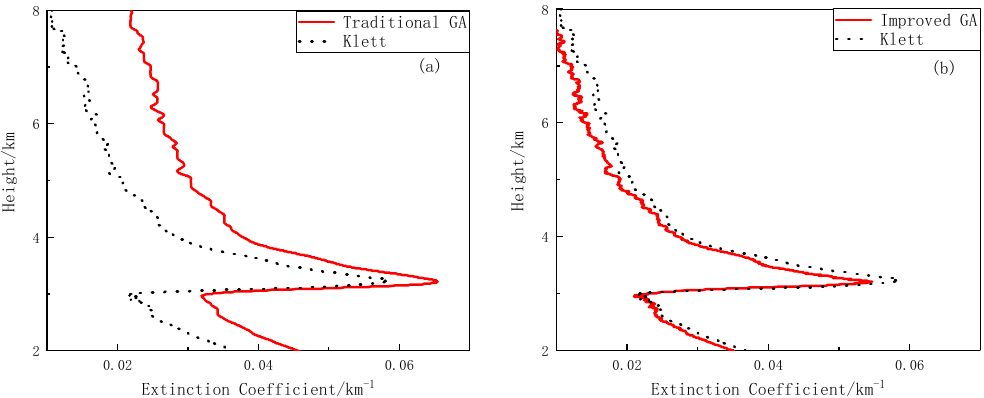
Figure 8. Inversion results obtained with one obvious layer of low cloud: ( a ) using the simple genetic algorithm and the Klett method, and ( b ) using the improved genetic algorithm and the Klett method.